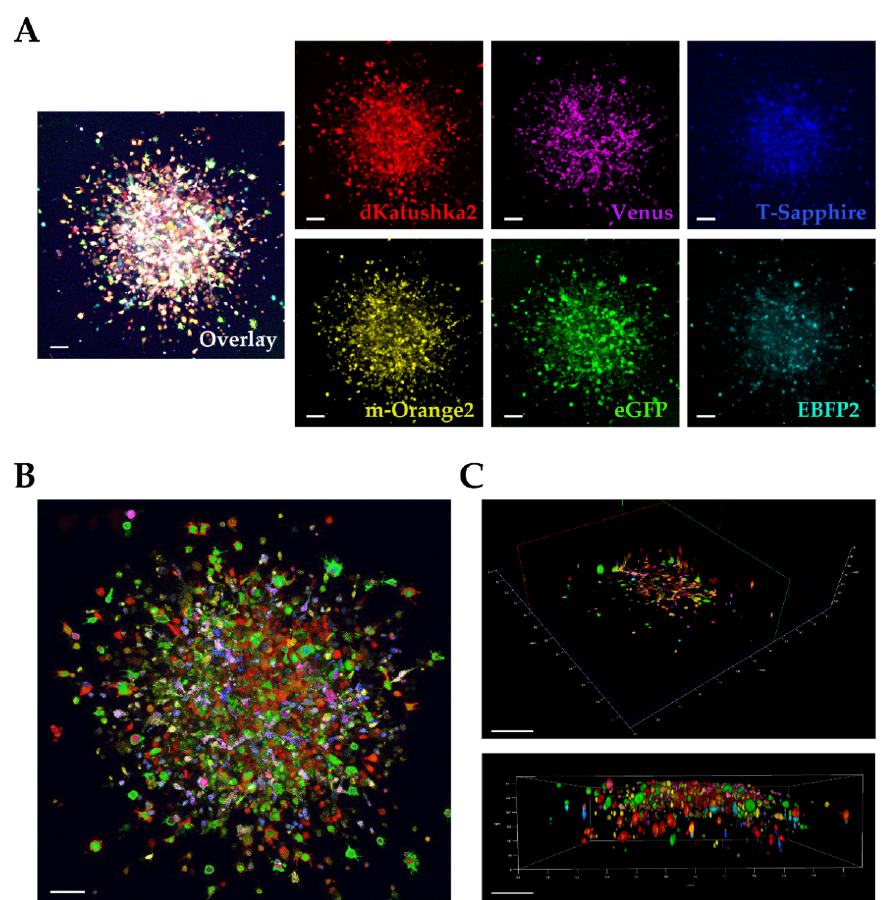
Figure 7. Multifluorescent in vitro 3D tumor invasion into Matrigel. ( A ) Maximum intensity projection (MIP) of z ‐ series and complete mosaic image of multifluorescent OPBG ‐ DIPG002 cell invasion is shown. The fluorescences of invading cells are shown in red (dKatushka2), yellow (m ‐ Orange2), magenta (Venus), green (eGFP), blue (T ‐ Sapphire), and cyan (EBFP2). Sequential confocal images were acquired using 10× or 20× objectives (Leica Microsystems) with a 1024 × 1024 format, and z ‐ step size of 1 μ m. Scale bar: 100 μ m. Images are relative to end point invasion assay (96 h). ( B , C ) Deconvolution analysis (HyVolution2 software, Huygens) was applied to z ‐ stacks to improve contrast and resolution of confocal raw images, then deconvolved images were imported into LASX 3D (Leica Microsystems) software to obtain their surface 3D rendering. Scale bars: 100 μ m in ( B ), 200 μ m in ( C ).